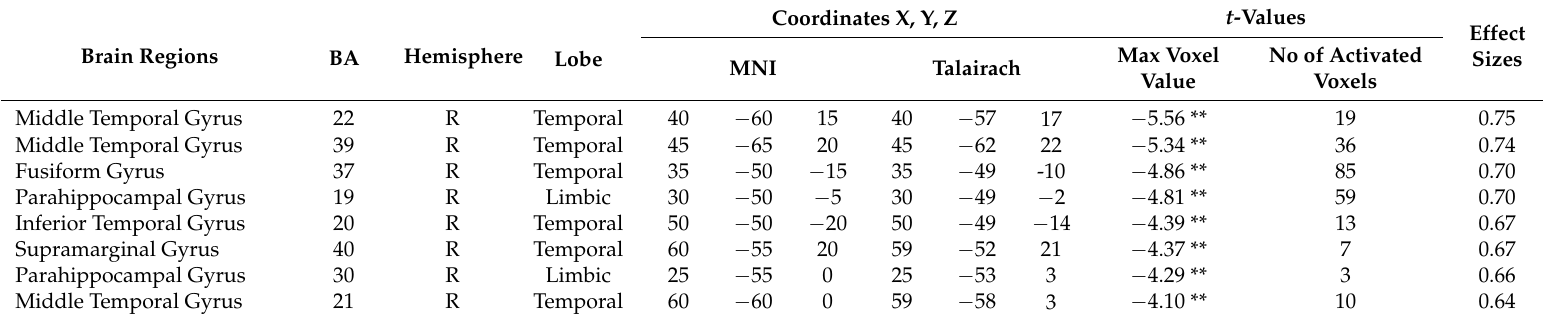
Table 6. Standardized low-resolution brain electromagnetic tomography (sLORETA) results of maximal brain electrical activity for the TD vs. BFRB group difference (at 324 ms